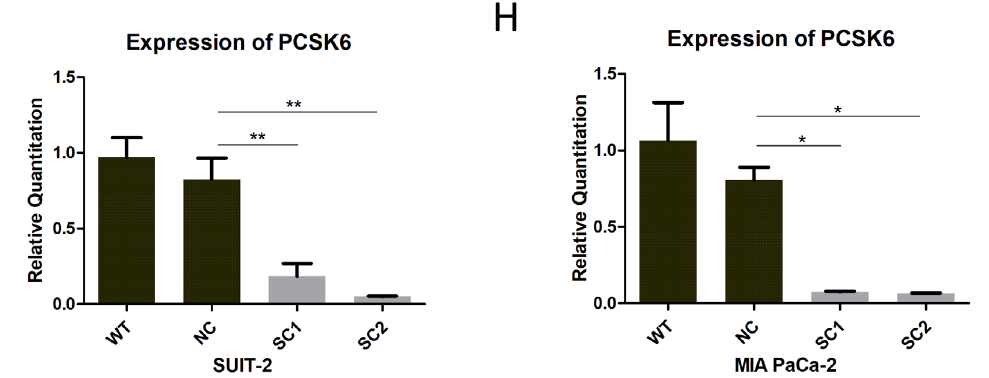
Figure 2. Prognostic analysis of candidate genes and knockout of PCSK6 in the cell lines SUIT-2 and MIA PaCa-2. ( A ) Lasso Cox regression analysis of 29 liver metastasis related genes. y -axis represents lasso coefficients and x -axis represents -log (Lambda) values. ( B ) Cross validation of the obtained genes via Lasso Cox regression. y -axis represents partial likelihood deviance and x -axis represents -log (Lambda) values. Dotted vertical line indicates the minimum and 1 standard error of Lambda values. The minimum values of Lambda were used as punishment coefficients for analysis. ( C , D ) Forest plots of univariate and multivariate Cox analysis. Five genes ( p < 0.1) obtained via univariate analysis were further included in the multivariate analysis. ( E , F ) Kaplan–Meier survival plots of PCSK6 and C2. ( G ) Expression of PCSK6 mRNAs in SUIT-SCs and controls. ( H ) Expression of PCSK6 mRNAs in MIA-SCs and